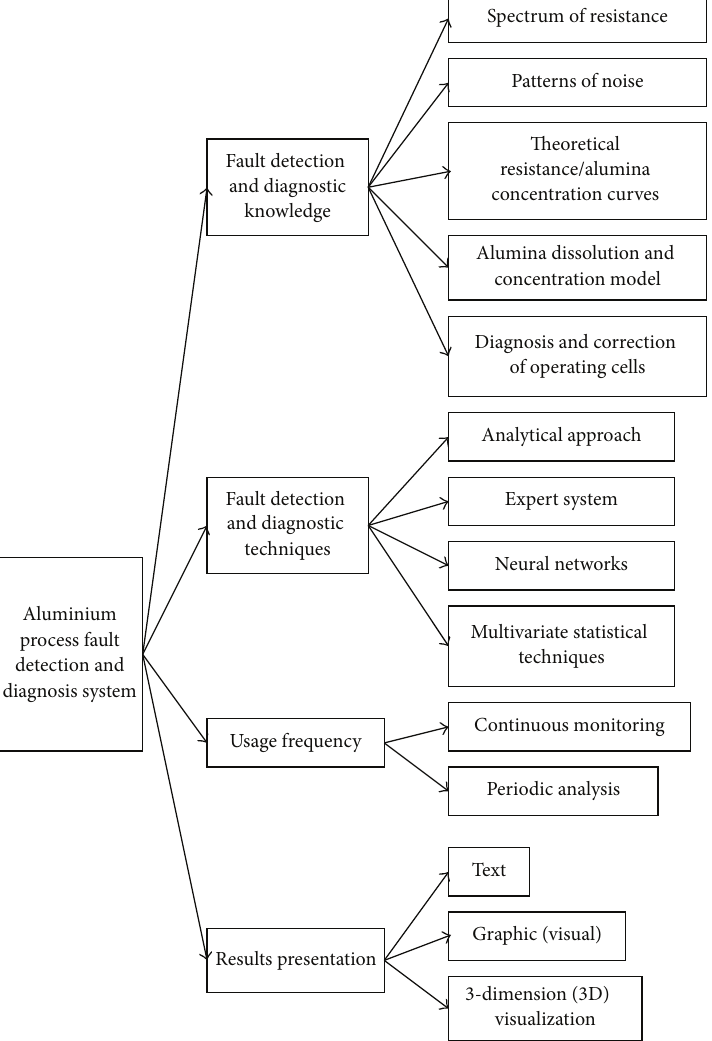
Figure 1: Taxonomy for aluminium process fault detection and